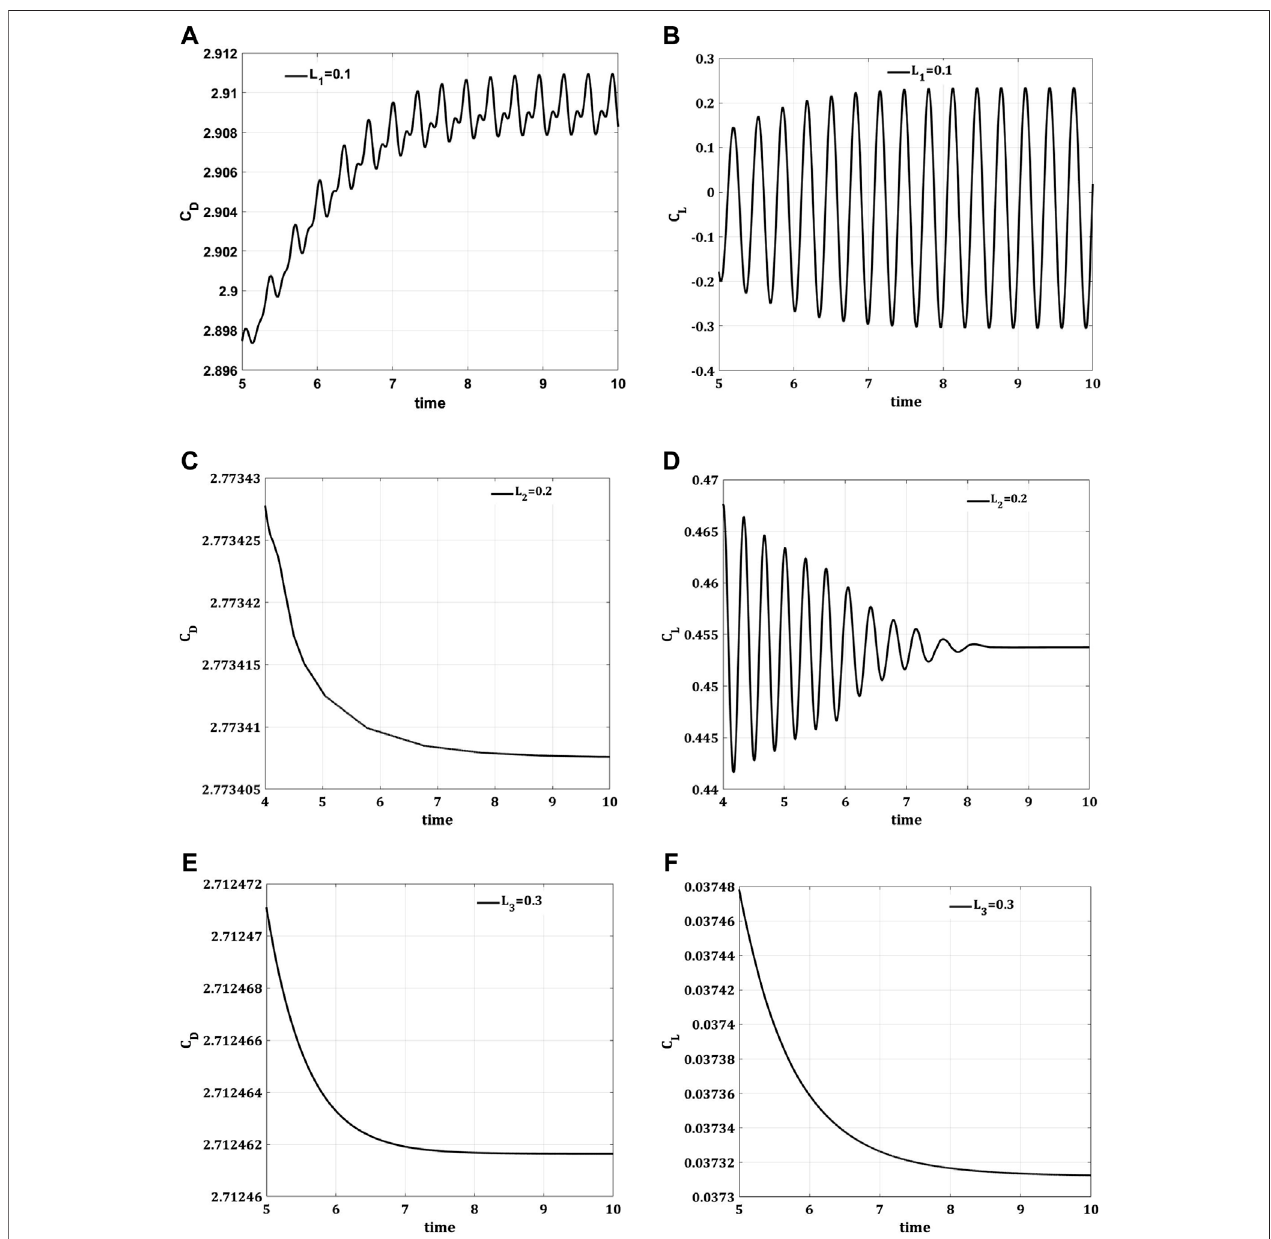
FIGURE 9 | Impact of an attached splitter plate of length (A,B) L 1 = 0.1, (C,D) L 2 = 0.2, (E,F) L 3 = 0.3 on drag coef fi cient (C D ) and lift coef fi cient (C L ) w.r.t time ( (cid:2) t ) , step size Δ t = 0.001.